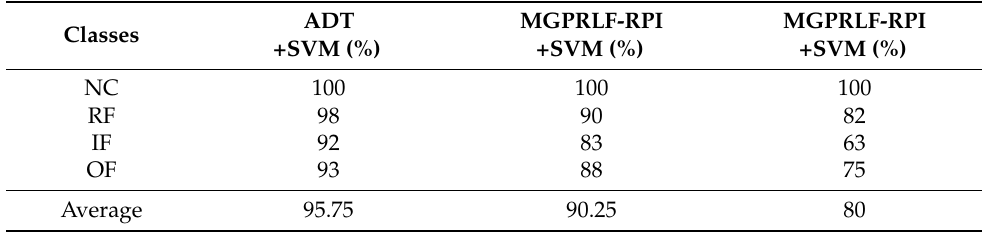
Table 5. The average accuracies of crack identification using ADT+SVM, MGPRLF-RPI+SVM, and MGPRLF-PI+SVM techniques. MGPRLF-PI+SVM techniques .